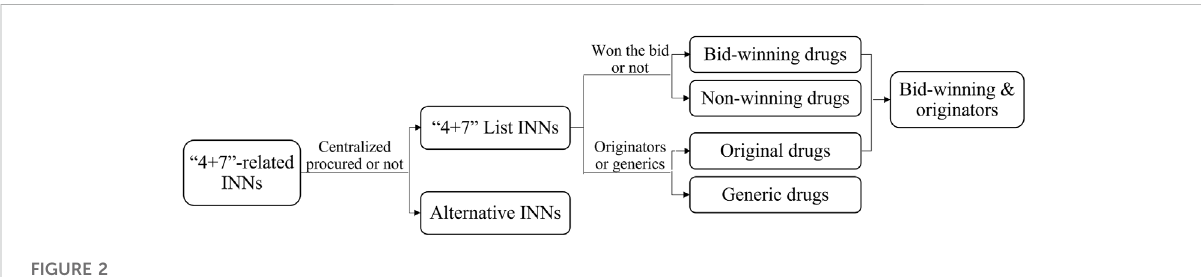
FIGURE 2 The classi fi cation of included